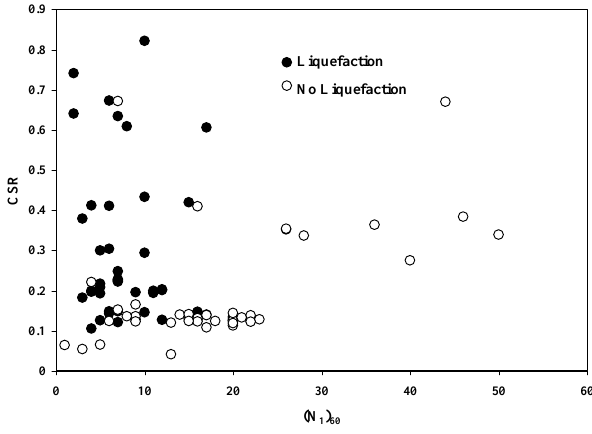
Fig. 7. Plot between PGA and (N 1 ) 60 for MODEL I using training Figure 7. Plot between PGA and (N 1 ) 60 for MODEL I using training dataset for ANN dataset for ANN model. model.